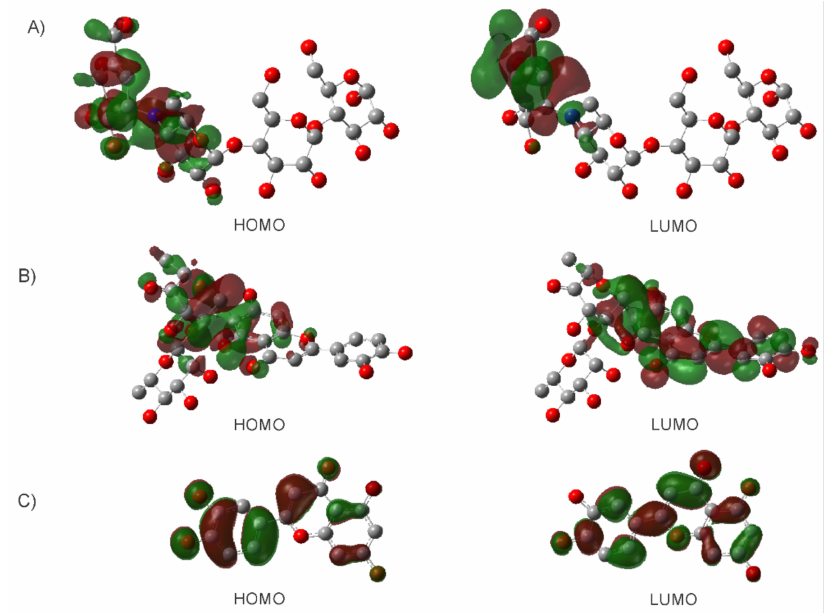
Figure 2. Frontier Molecular Orbitals for ( A ) acarbose (ACA), ( B ) maysin (MAY), and ( C ) luteolin (LUT) calculated with the M06/6-31G (d) level of